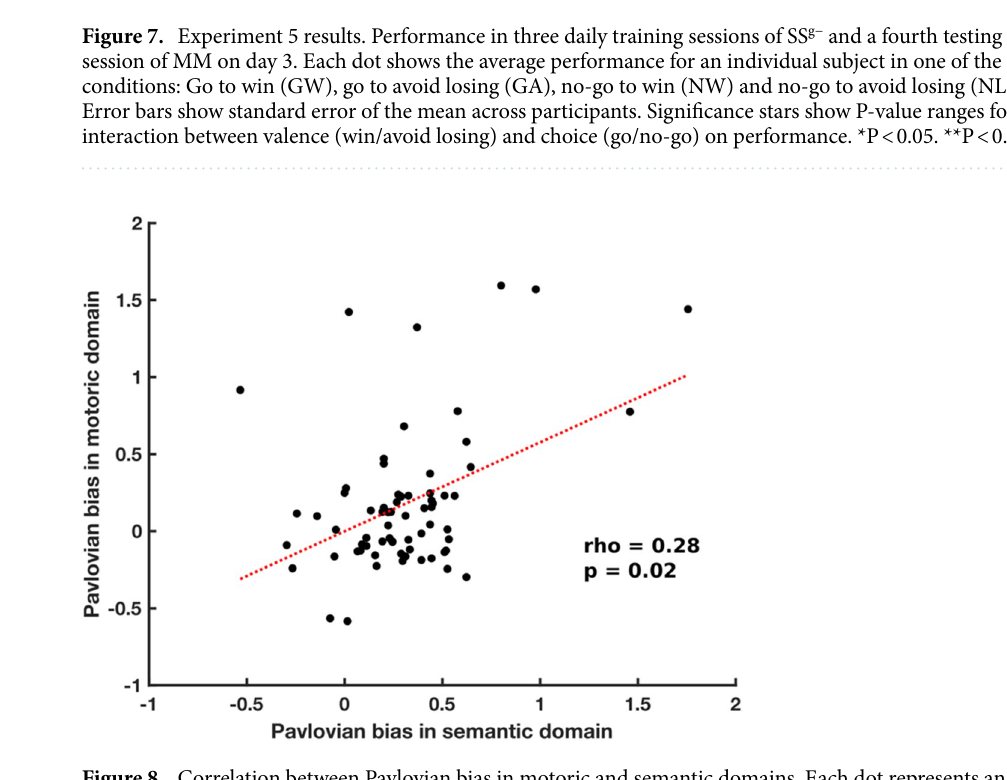
Figure 8. Correlation between Pavlovian bias in motoric and semantic domains. Each dot represents an individual subject. Data was pooled from experiments 1, 2 and 5. For each subject, a Pavlovian bias was computed in the motoric domain and in the semantic domain. These two Pavlovian biases are plotted against each